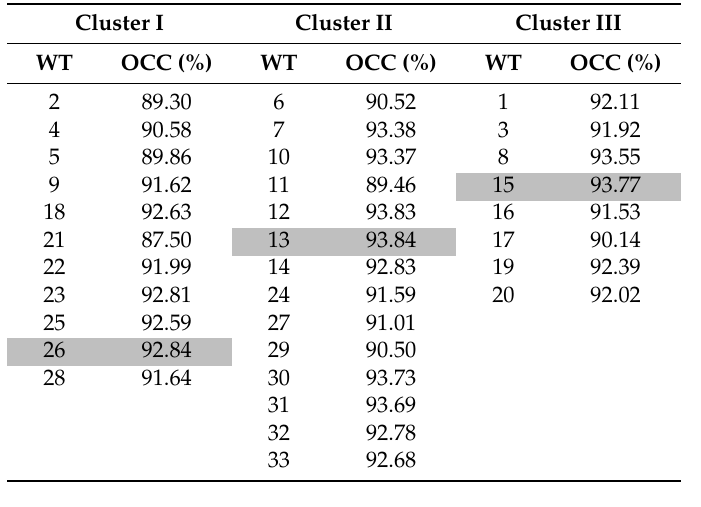
Table 1. The optimal clustering scheme and OCC statistics of all wind turbines. ( k = 3).